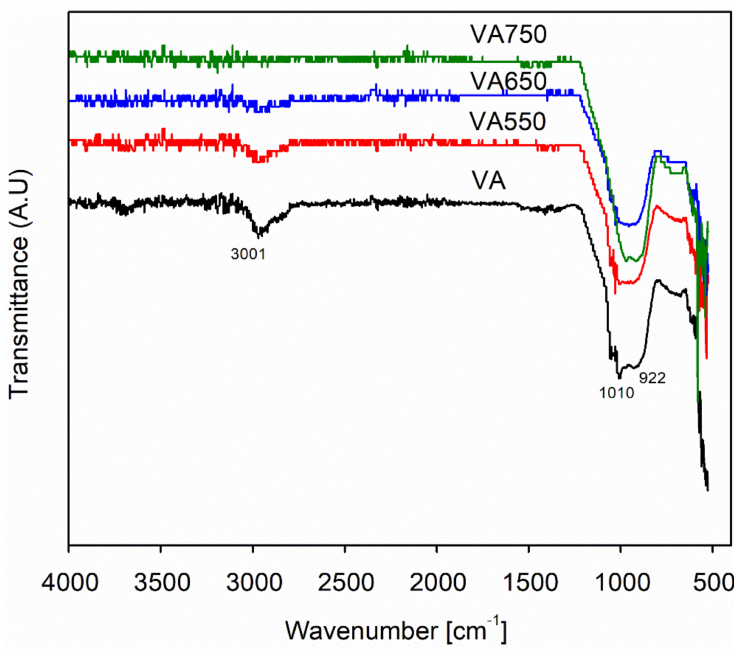
Figure 6. FTIR intensities for untreated VA and heat-treated VA at 550, 650, and 750 ◦